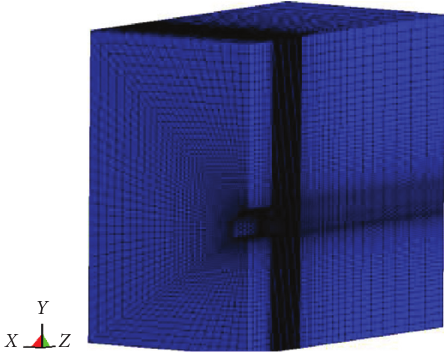
Figure 10: Numerical calculation model.